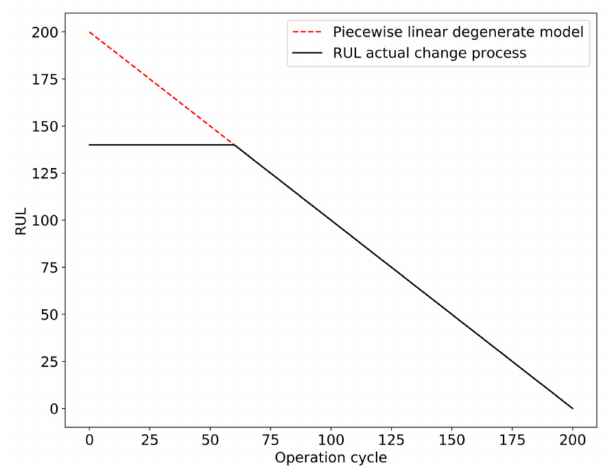
Figure 5. Piecewise linear degradation